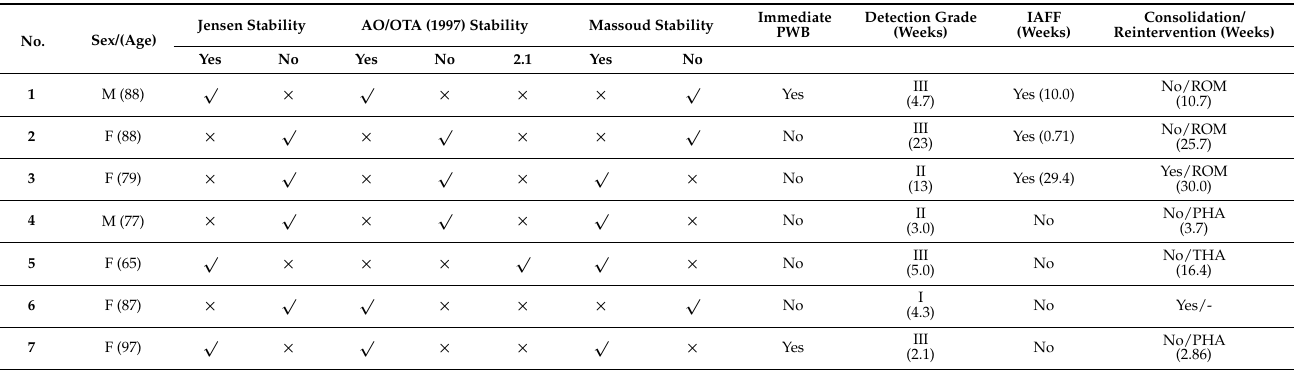
Table 4. Summary of the early cut-out cohort. (M, male; F, female; AO/OTA, AO Founda- tion/Orthopaedic Trauma Association classification; PWB, partial weight bearing; IAFF, infection after fracture fixation; ROM, removal of osteosynthesis material; PHA, partial hip arthroplasty; THA, total hip